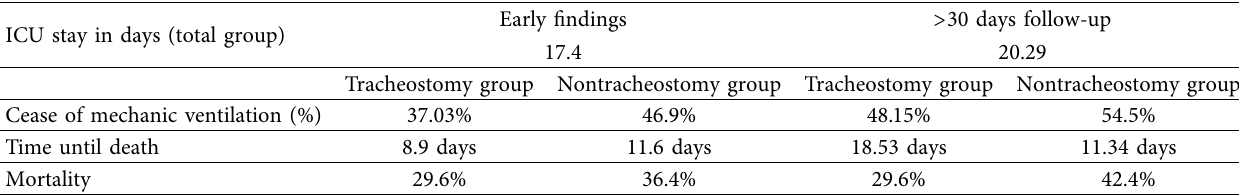
Table 2: Comparison between early and long-term results and tracheostomy vs nontracheostomy in COVID-19 patients. ICU stay in days (total group)